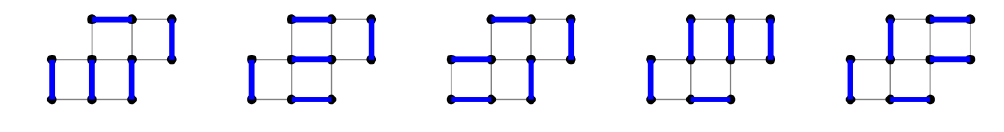
Figure 2. Snake graph G f ( 2,2,2 ) = G [ 5 ] and its perfect